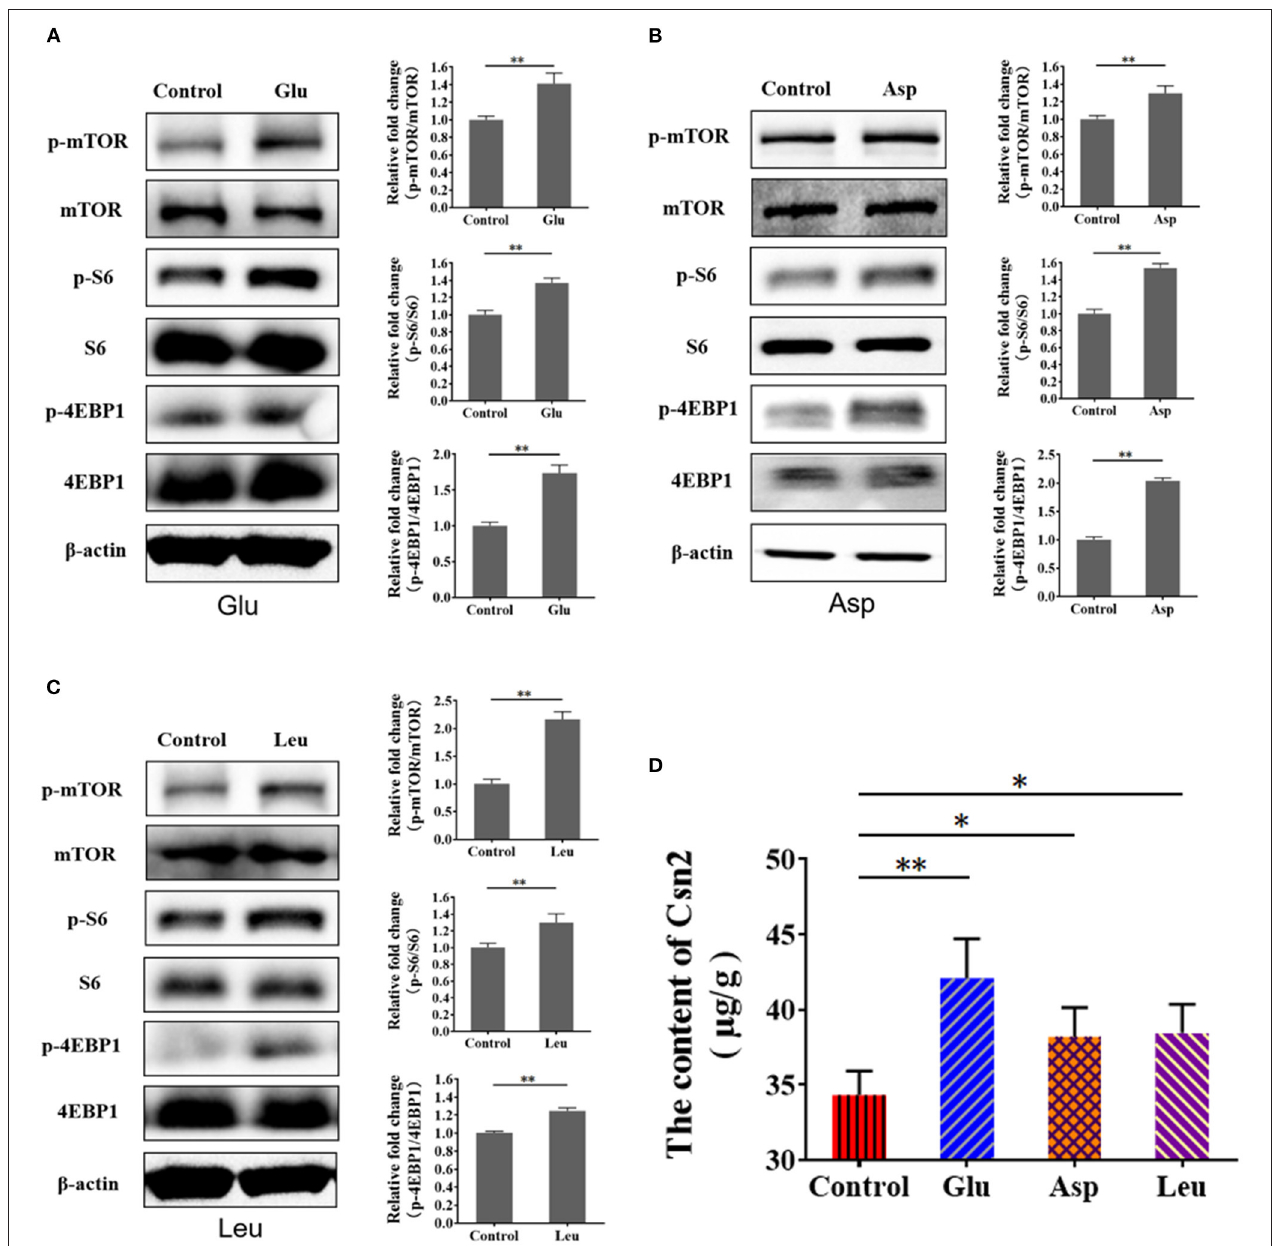
FIGURE 3 | Exogenous amino acid promotes mTORC1 activation and CSN2 ( β -casein) synthesis. (A–C) Western blot of mTORC1 activation after BMEC stimulation with Glu (A) , Asp (B) , and Leu (C) . Phosphorylation of mTOR, S6, and 4EBP1. (D) Intracellular Csn2 ( β -casein). The resolved bands were quantified using Gel-Pro Analyzer 4.0 (Media Cybernetics, Inc., Rockville, MD, USA). * p < 0.05; ** p < 0.01. n = 3 independent